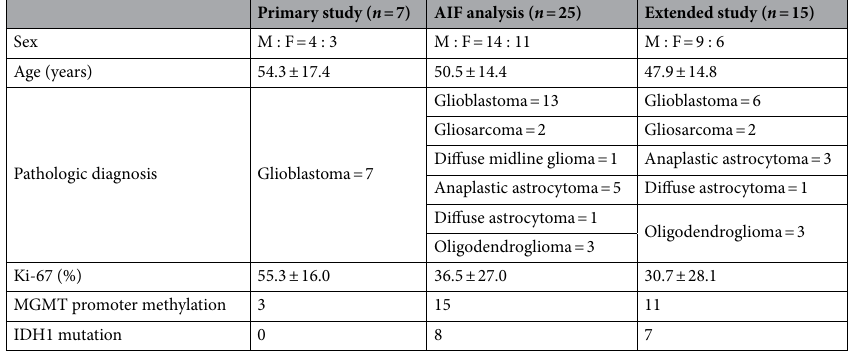
Table 1. Demographics and pathologic results of study population. M male, F female, MGMT O 6 -